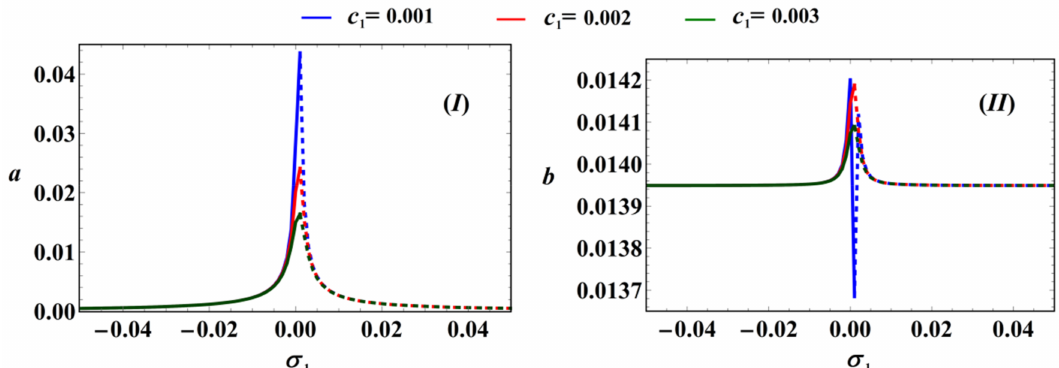
Figure 9. The frequency response at σ 2 = 0.001, W = 0.448, and c 2 = 0.011 of: ( I ) a ( σ 1 ) and ( II ) b ( σ 1 ) .